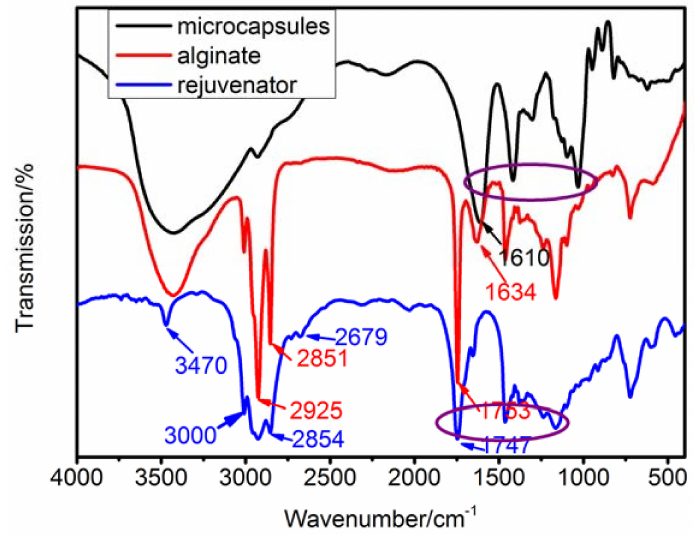
Figure 4. FT-IR test of microcapsules, alginate, and